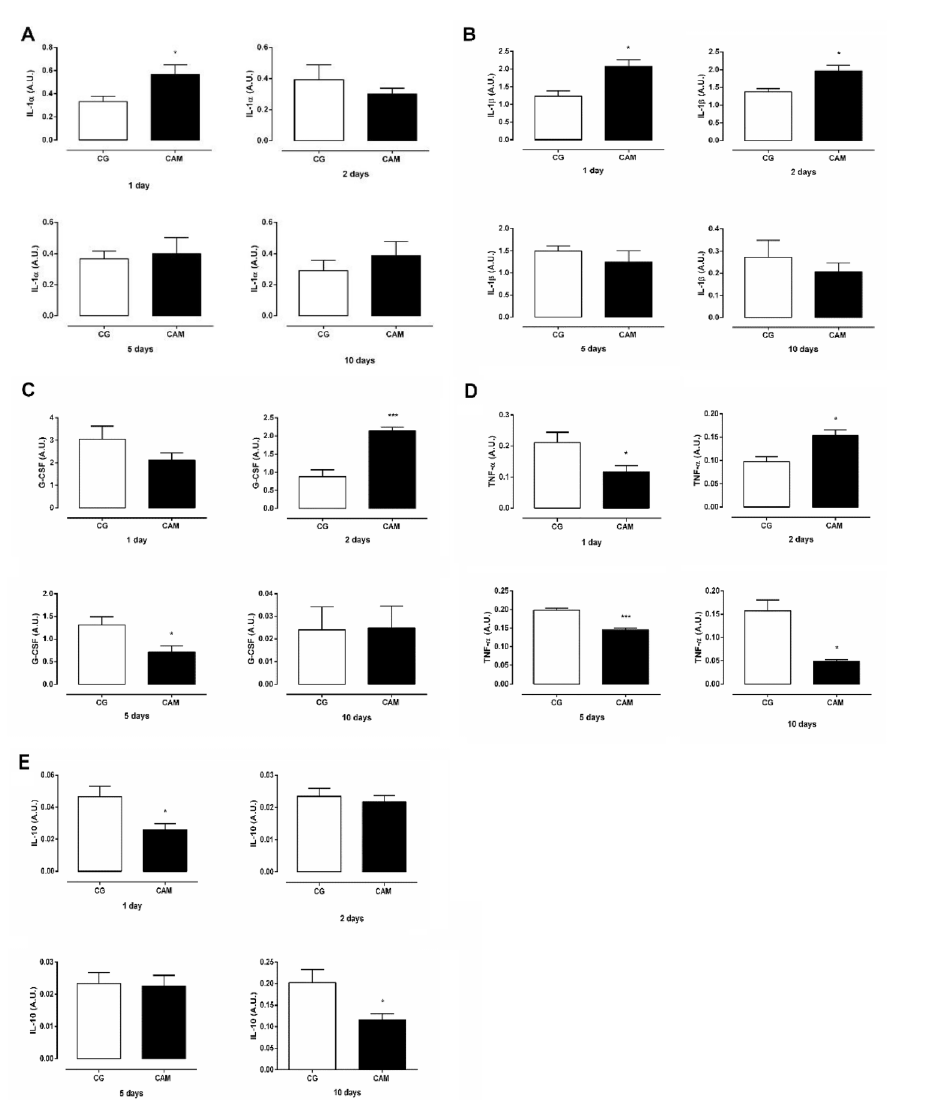
alginate membrane (CAM) groups on days 1, 2, 5, and 10 post-wounding. Data are reported as means ± SE of 5 animals per group. *P o 0.05, ***P o 0.001 vs CG (Student ’ s t